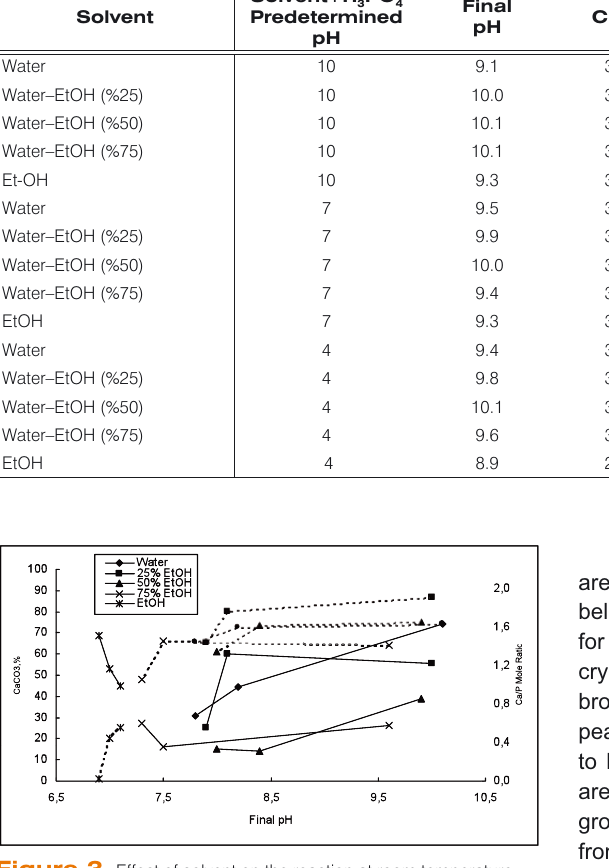
Figure 3. Effect of solvent on the reaction at room